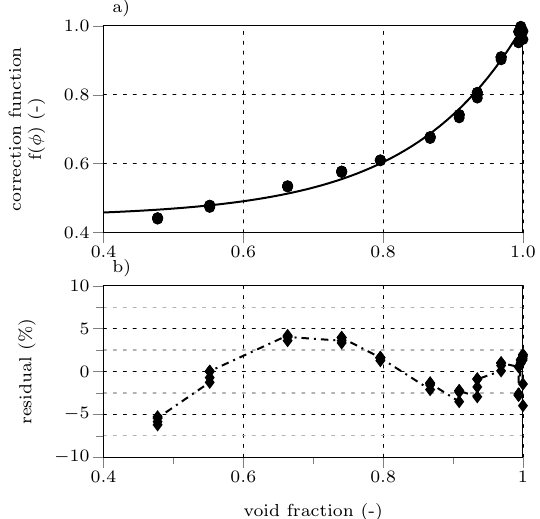
Figure 9. Comparison ( a ) of the radiation correction function ( ) given by Equation (13) and simulation data ( ). The relative errors of Equation (13) compared to CFD-simulated data is presented in ( b